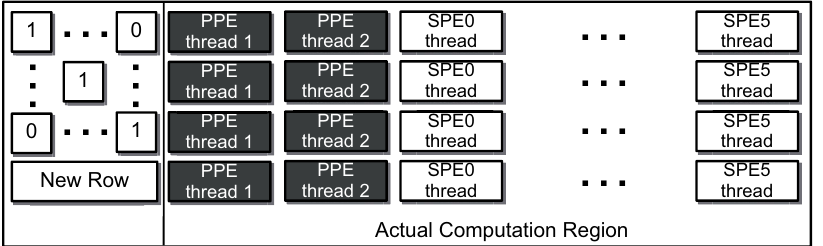
Figure 7. Dynamic resource distribution to Cell